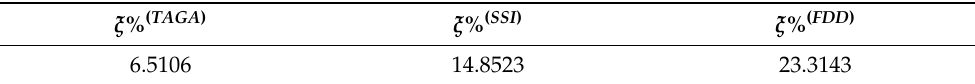
Table 10. Discrepancy between the estimated structural responses and the exact ones for the 5DoF Table 9. Discrepancy between the estimated FRF matrix in nodal space and the exact one for the 5DoF system.